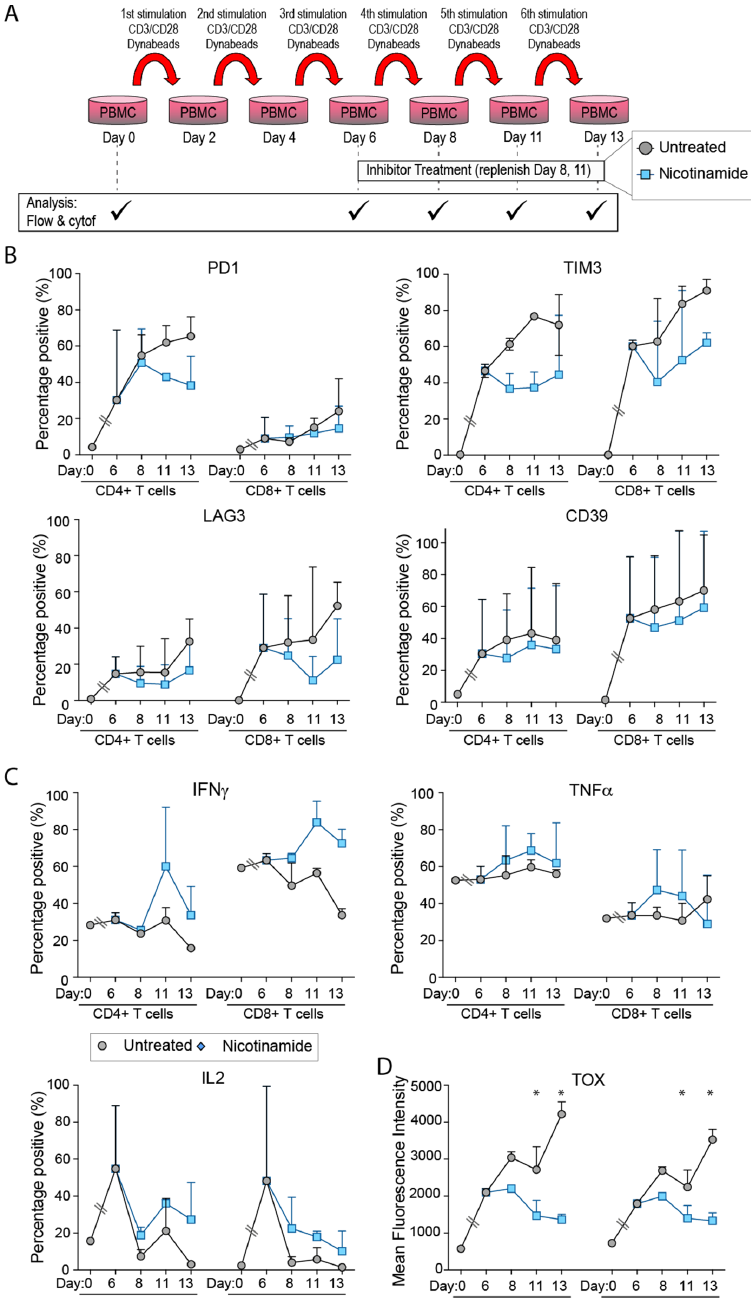
Figure 5. The effects of EZH2i and NAM in established exhausted T cells. NAM treatment down regulates TOX, induces decrease in the expression of TIM3 and LAG3 and increases in the production of IFN and IL-2. ( A ) Schematic showing experimental set up. Time course shown for average across independent experiments, whereby CD3/CD28 bead stimulation until day six was without inhibitor treatment (black line) with inhibitor treatment concurrent with CD3/CD28 bead stimula- tion thereafter, showing ( B ) Means and standard deviations of expression of IRs, ( C ) cytokines and ( D ) transcription factors as per Figures 1–3. TOX, EZH2 and H3K27me3 mean fluorescent intensity (MFI) were calculated for each time point. Statistical significance between treated and untreated indicated by * as determined using the Holm-Sidak method ( α = 0.05).